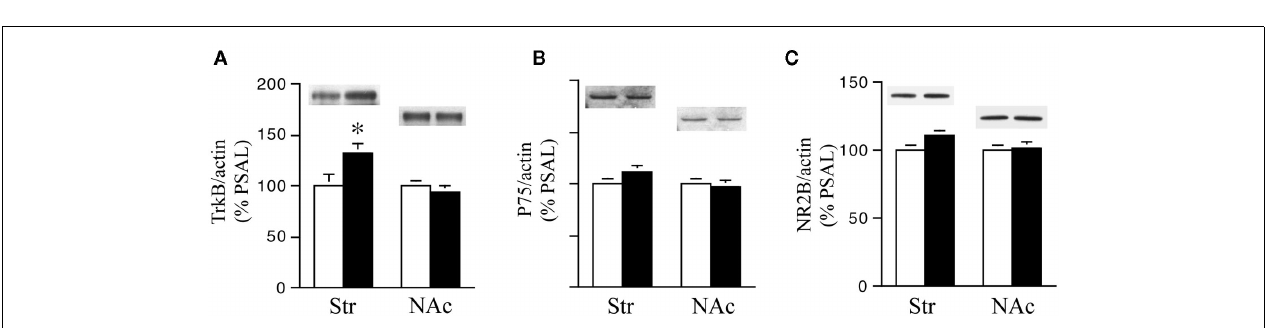
were significantly higher in the striatum of PCOC mice compared to PSAL mice (* p < 0.05), while no difference was observed in the NAc. No differences in the levels of p75 (B) or NR2B (C) were observed in the Str or NAc of PCOC mice compared to PSAL mice. Error bars represent ± SEM. N = 5–6